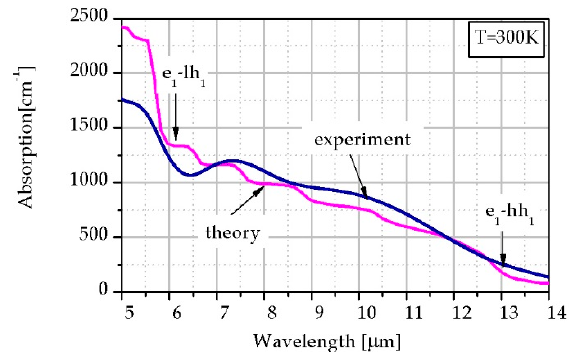
Figure 9. α theoretical simulation and experimental data for T2SLs InAs / InAs 0.62 Sb 0.38 with L = 13.2 nm at T = 300 K.